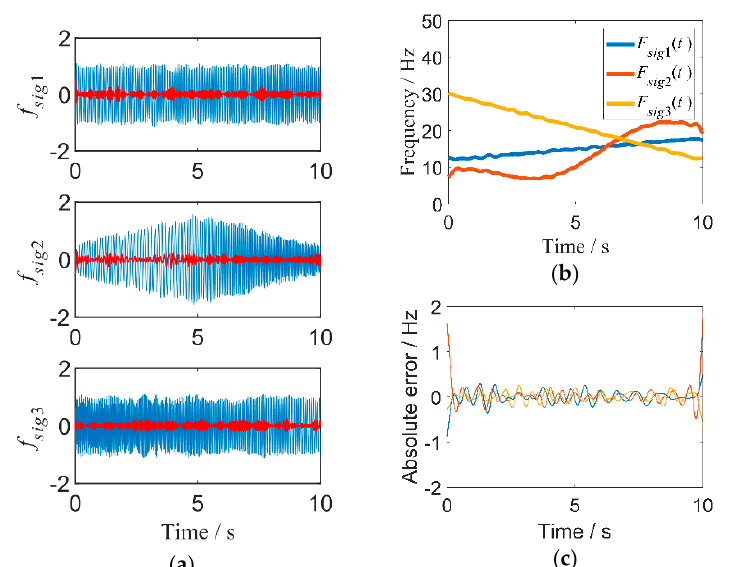
Figure 4. Analysis results with SNR = 12 dB. ( a ) The estimated modes by VSME. ( b ) Frequency of estimated component signal extracted by VSME. ( c ) Absolute error of estimated component signal frequency extracted by VSME.